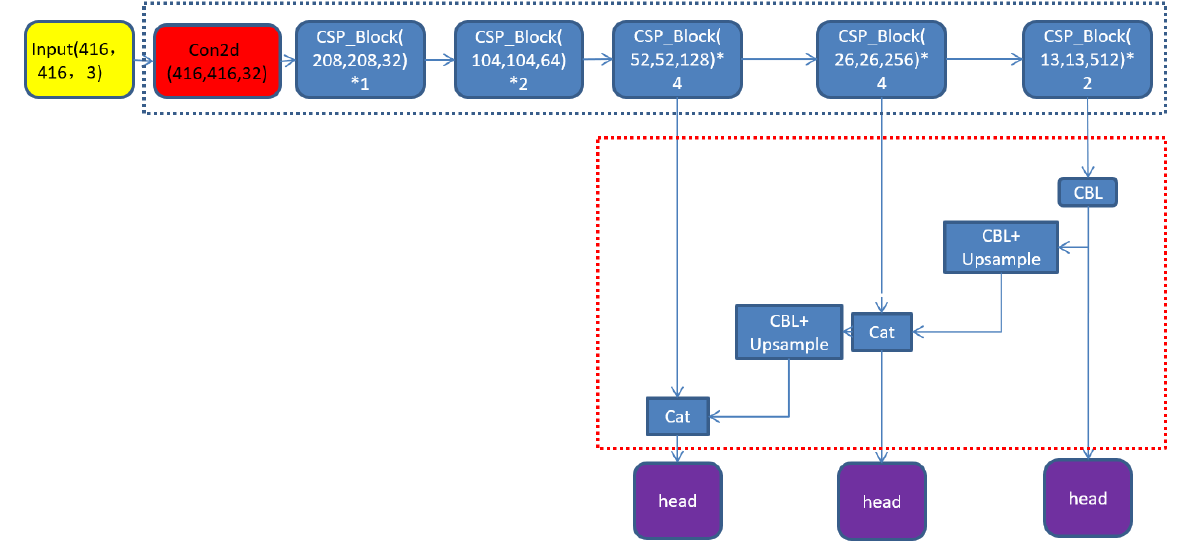
Figure 3. Structure diagram of CSP.